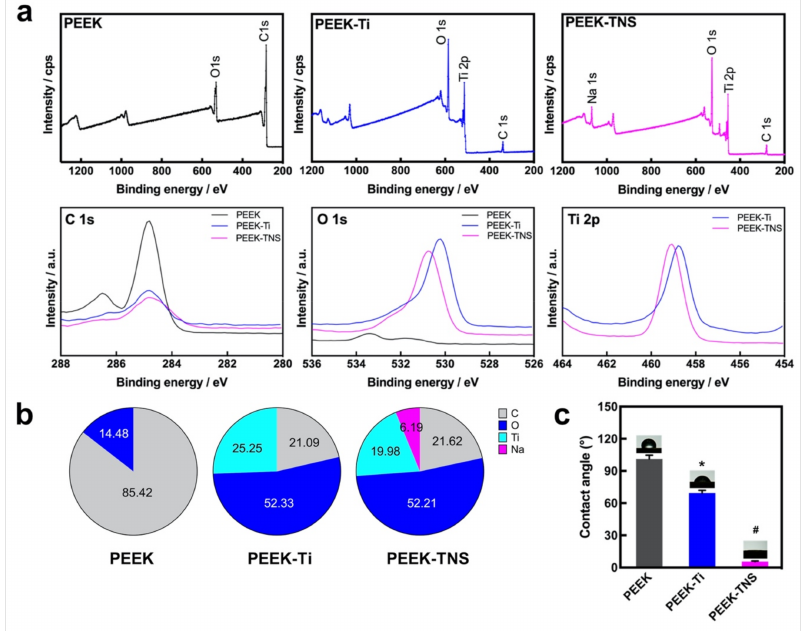
Figure 2. Surface chemical characteristics of PEEK, PEEK-Ti, and PEEK-TNS. ( a ) XPS survey spectra of PEEK, PEEK-Ti and PEEK-TNS by a wide analysis, and XPS survey spectra of C 1s, O 1s, and Ti 2p peaks. ( b ) Elemental composition. ( c ) Water contact angles. (* represents p < 0.05 when PEEK-Ti is compared with PEEK; # represents p < 0.05 when PEEK-TNS is compared with